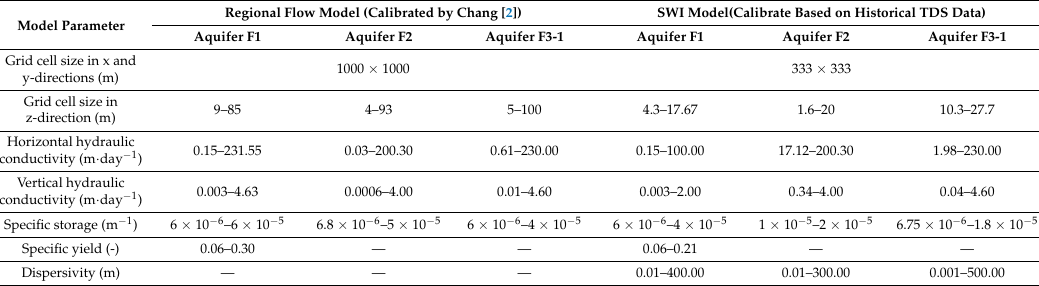
Figure 5. The scatter plot of sim and meas. of water levels by regional flow model (Chang [2]). Table 1. The parameter values of Pingtung Plain groundwater flow model and SWI